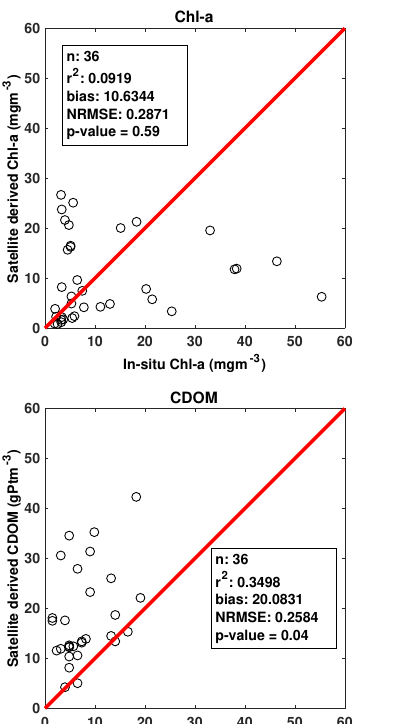
Figure 4. Histogram of the in situ and satellite-derived (S3) water quality concentrations: Chl-a ( top ), CDOM ( bottom-left ) and TSM ( bottom-right ).